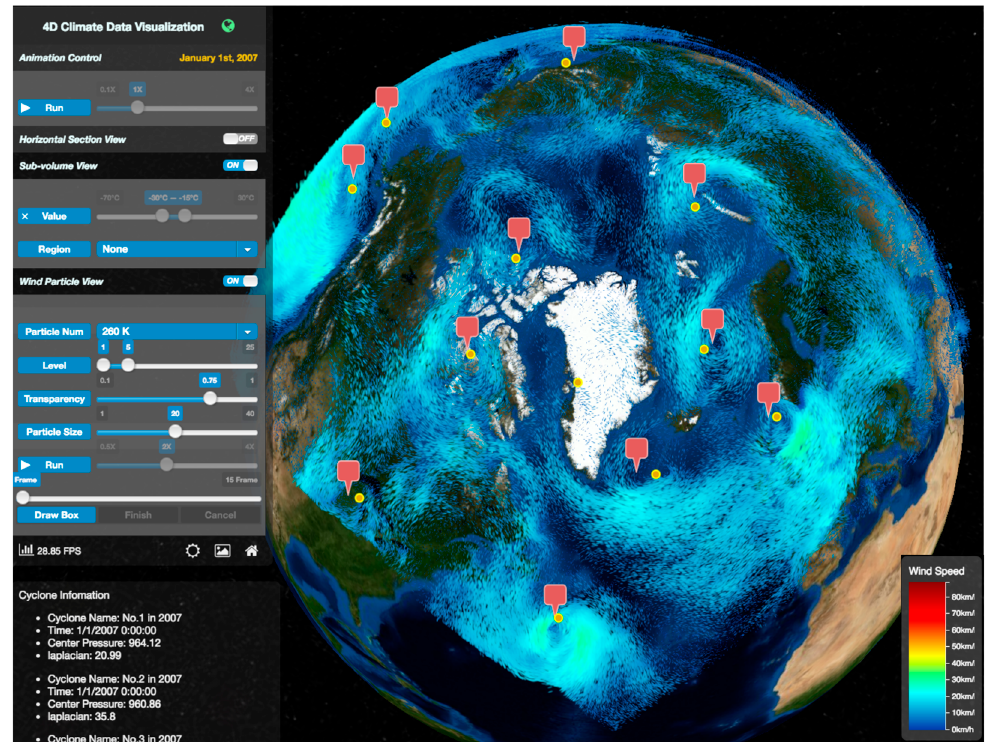
Figure 11. The comparison of the identification results with the NCEP/NCAR reanalysis data. Our identification output is marked with red balloons and the NCEP data is marked with yellow circle points.